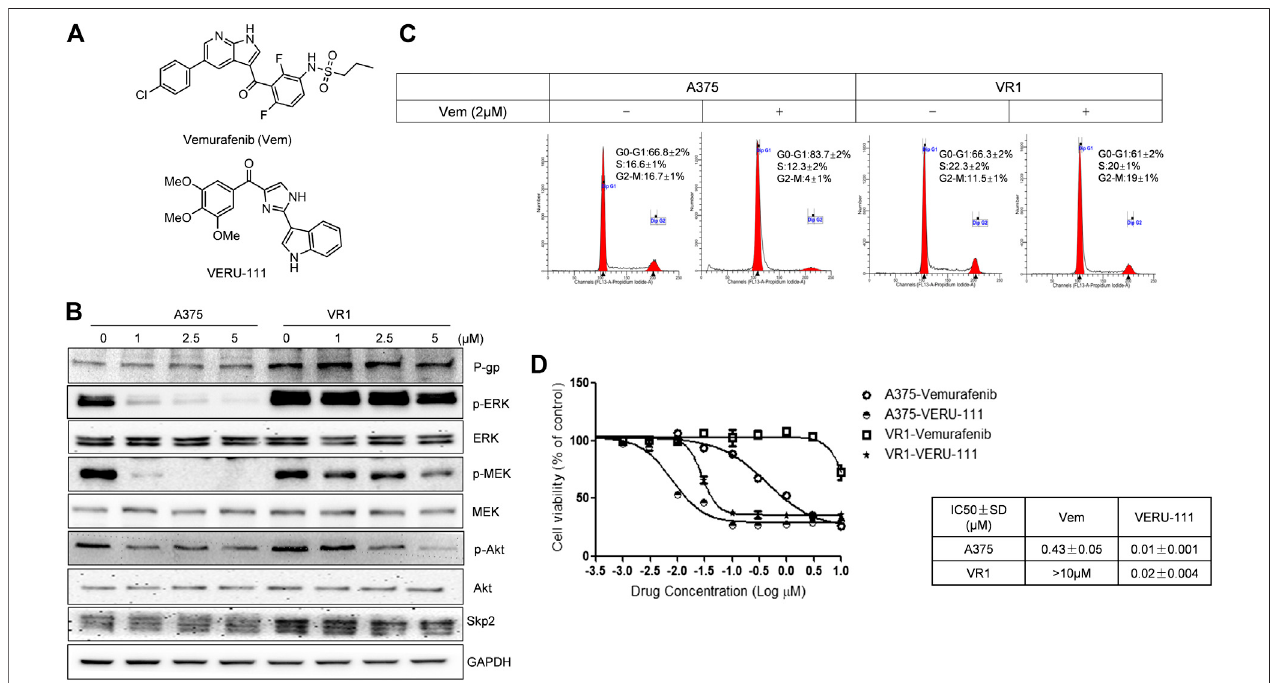
FIGURE 1 | VERU-111 is ef fi cient in both A375 and A375-Vem resistant (VR1) cells (A) Structure of compound Vemurafenib (Vem) and VERU-111 (B) p-ERK/p- MEK is persistantly expressed in VR1 cells (C) Vem treatment leads to G0-G1 arrest in both parental A375 and Vem-resistant VR1 cell (D) MTS assay to test IC 50 in parental A375 melanoma and VR1